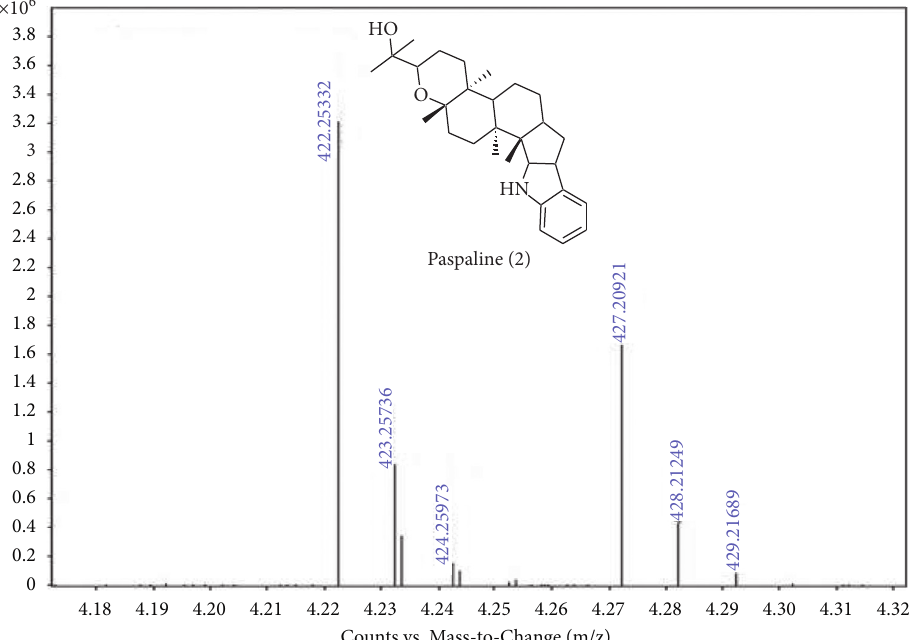
Figure 2: LC-ESI-MS chromatogram of a base peak [ M + H ] + with m/z 422.25332 at 7.84min present in SPE4 fraction of A. corniculatum for the identified indole-diterpenoid compound ( 2